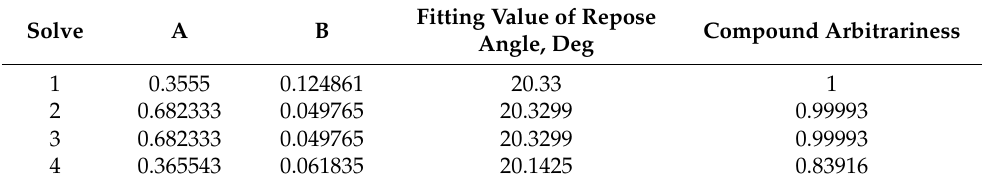
Table 7. Parameter optimization results of JD17.